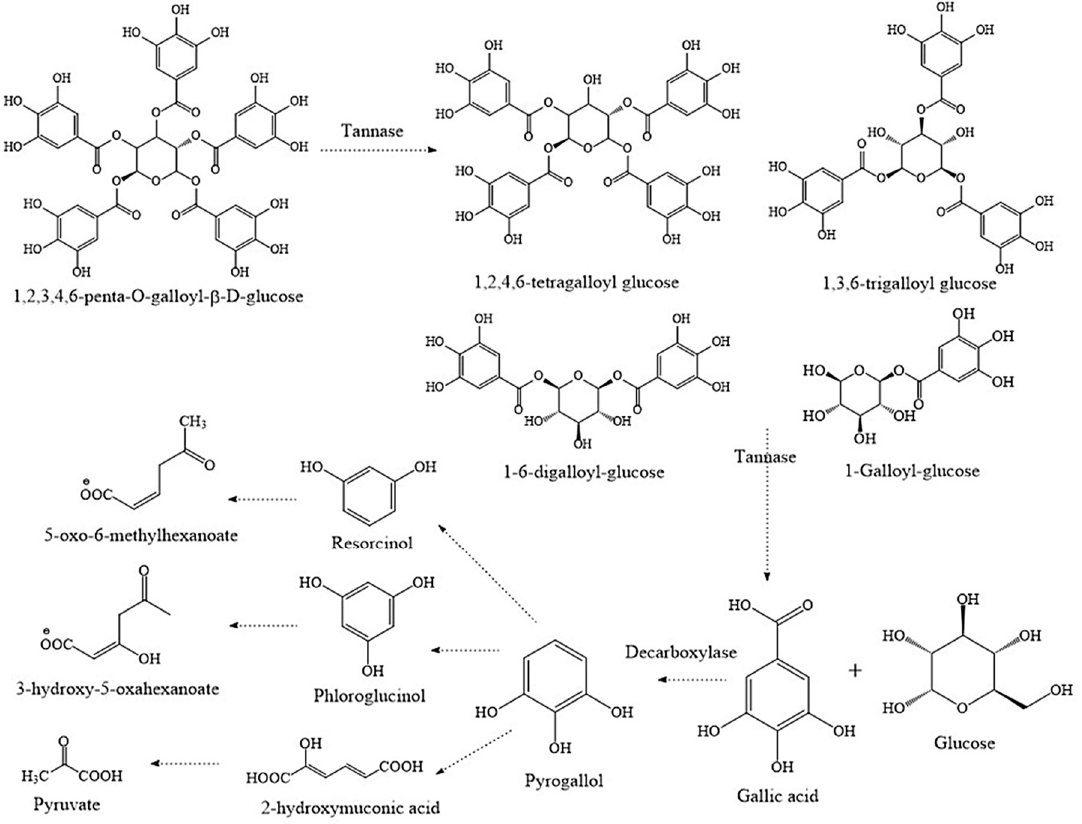
Figure 1. Biodegradation of tannins. Breakdown of gallotannins by tannase and other enzymes (original source).